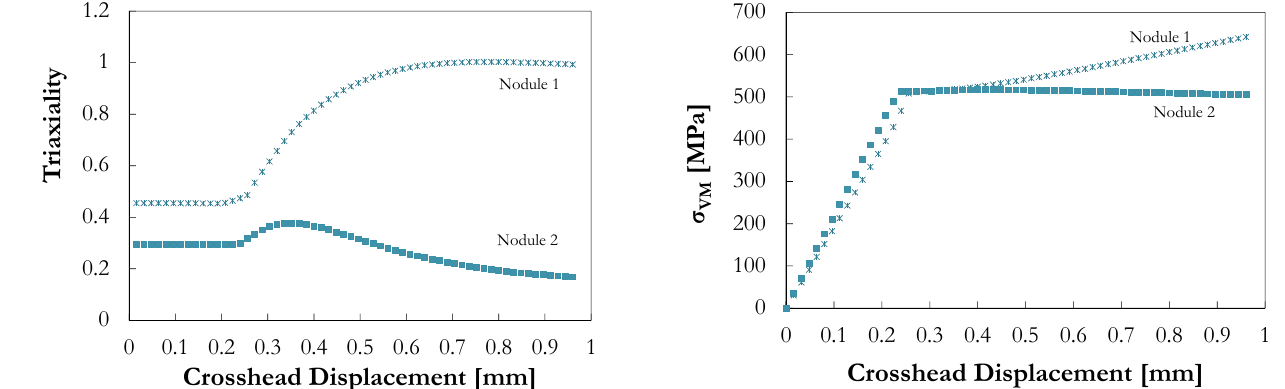
Figure 6: Equivalent Von Mises stress evolution with the crosshead